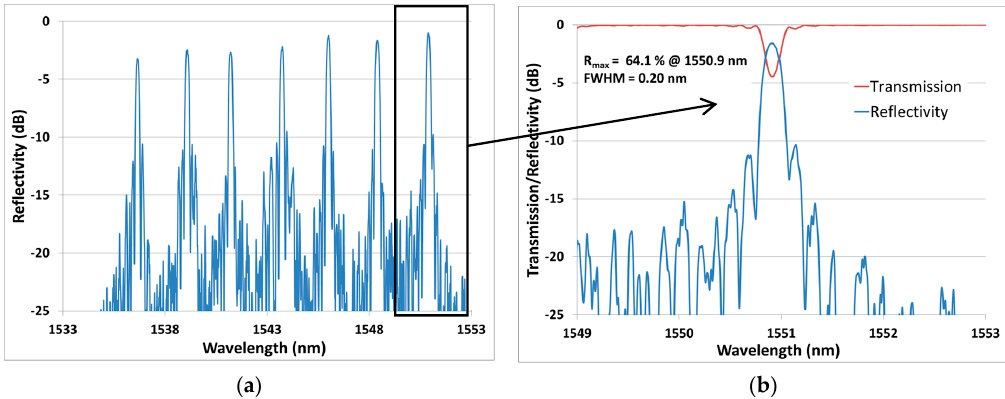
Figure 10. ( a ) Reflectivity spectrum of an array of seven FBGs (L = 5 mm) spectrally spaced by ~ 2.5 nm written in a Fibercore SM1500(9/125)P. ( b ) Zoom on the transmission and reflectivity spectra of one FBG.